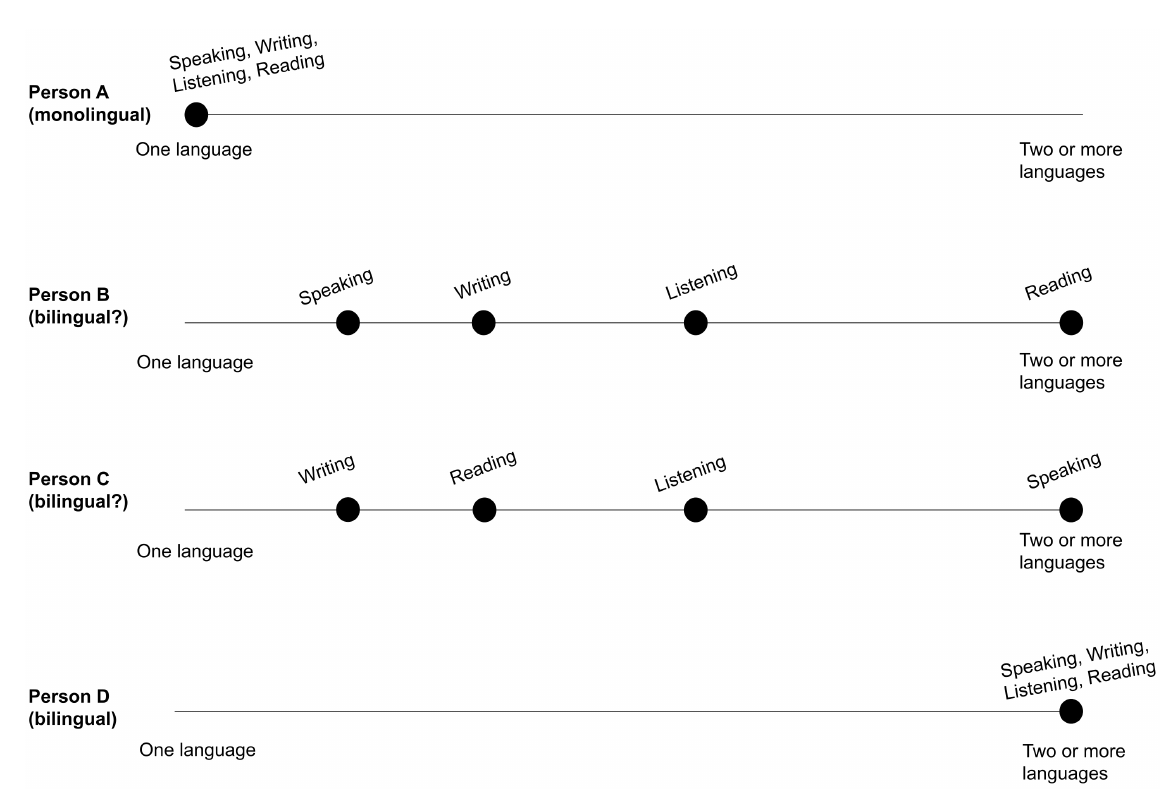
FIGURE 2 An improvement on Figure 1B is to think not of a single absolute continuum that applies to all people, but to acknowledge that each individual will have a continuum of skills they can employ in one language (left side) or in multiple languages (right side), or somewhere in the middle. As a monolingual, person A’s skills are all on the extreme left side of the continuum. Similarly, as a fully proficient bilingual, person D’s skills are all on the extreme right side of the continuum. Persons B and C have partial proficiency in more than one language but they differ from one another with respect to how advanced each of their skills is in more than one language. For instance, person B is fully proficient in speaking in one language but is very limited in other languages, while being able to read highly proficiently in more than one language; contrast this distribution with person